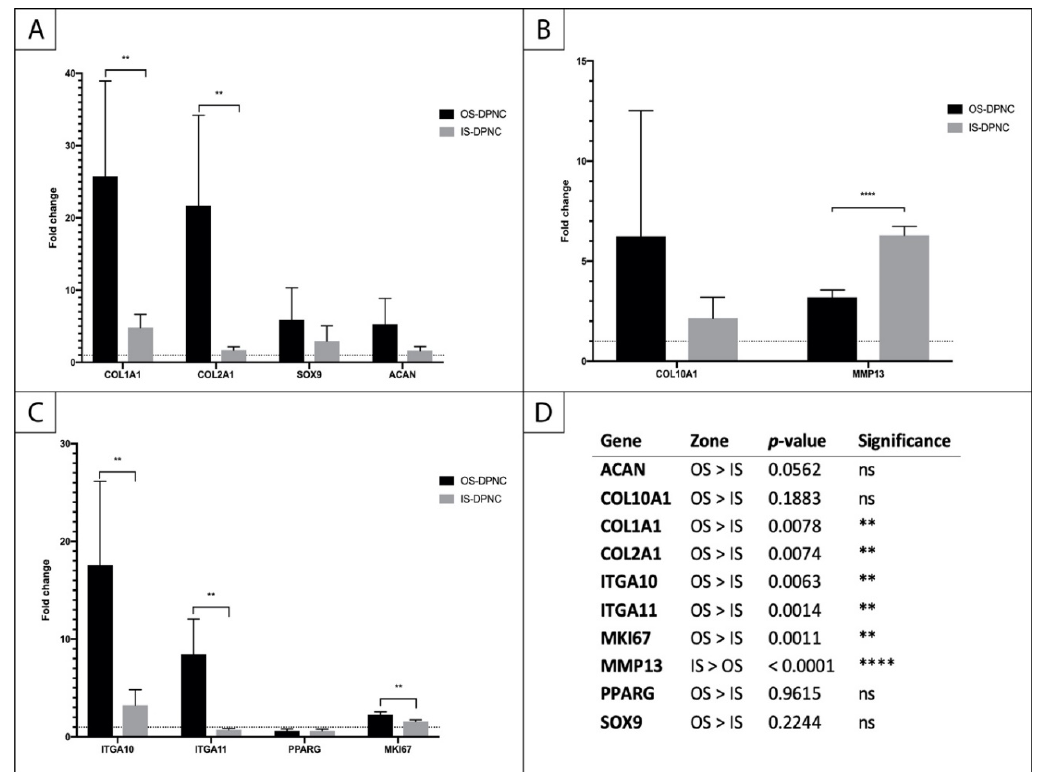
Figure 6. Relative changes in gene expression in ASCs seeded on IS and OS of DPNC. ( A ) early chondrogenic markers; ( B ) markers of chondrocyte hypertrophy; ( C ) integrins, adipogenesis and proliferation markers; ( D ) statistical analysis (n = 5; ** p < 0.01; **** p < 0.0001; mean ± SD).